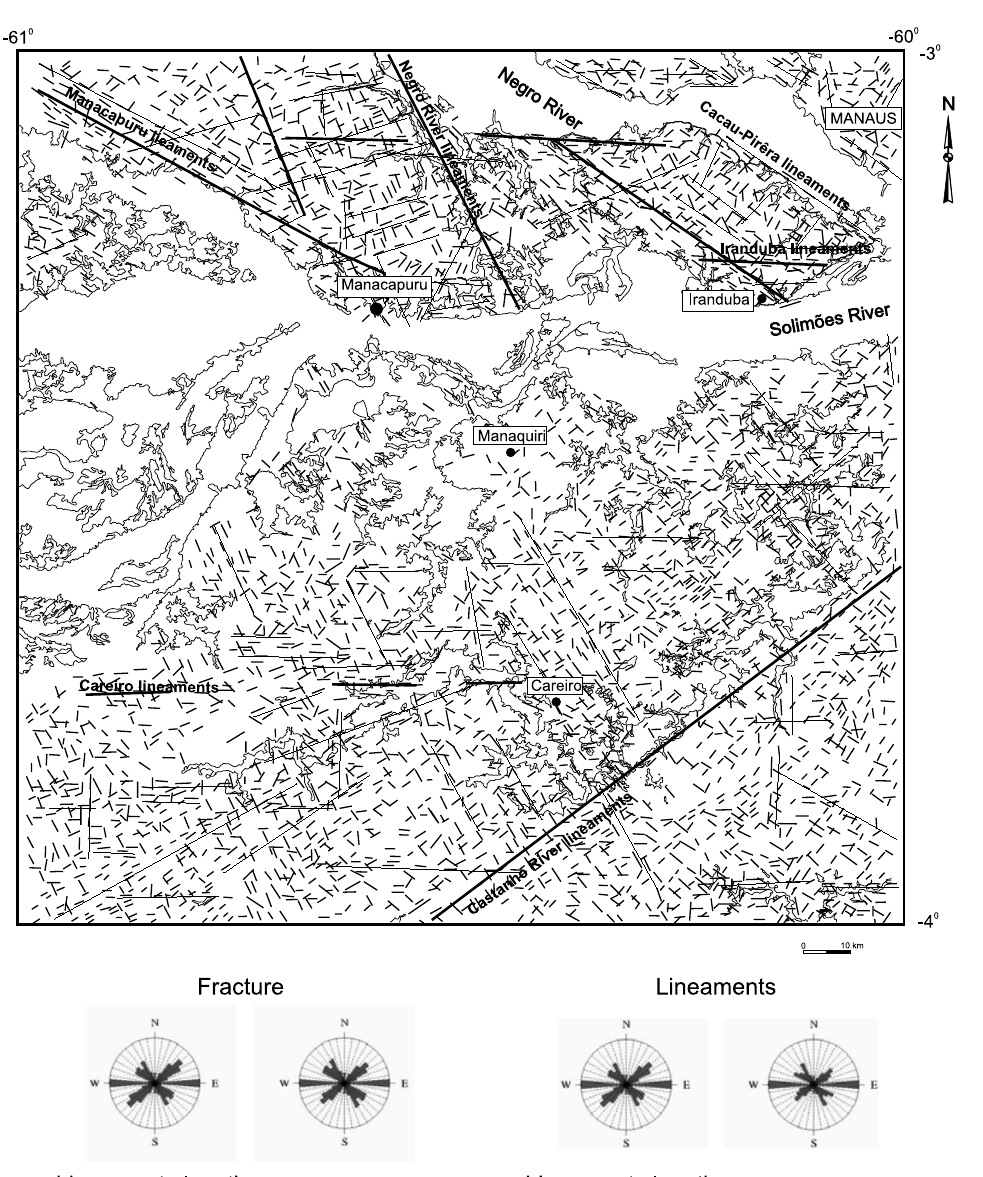
Fig. 8 – Lineament map of the study region from the integration of relief and drainage features obtained from Landsat TM images. Rose diagrams show the directions of the